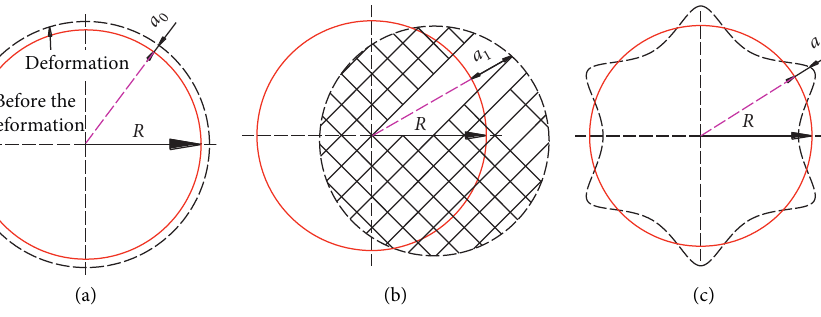
Figure 14: Radial displacement of each harmonic component. (a) a